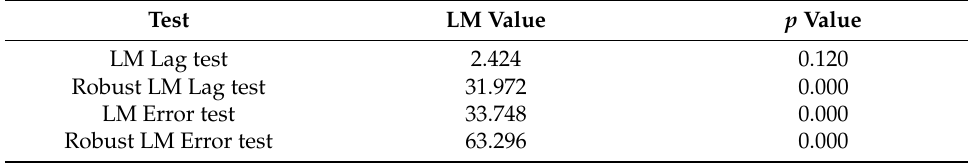
Table 6. LM inspection results table.